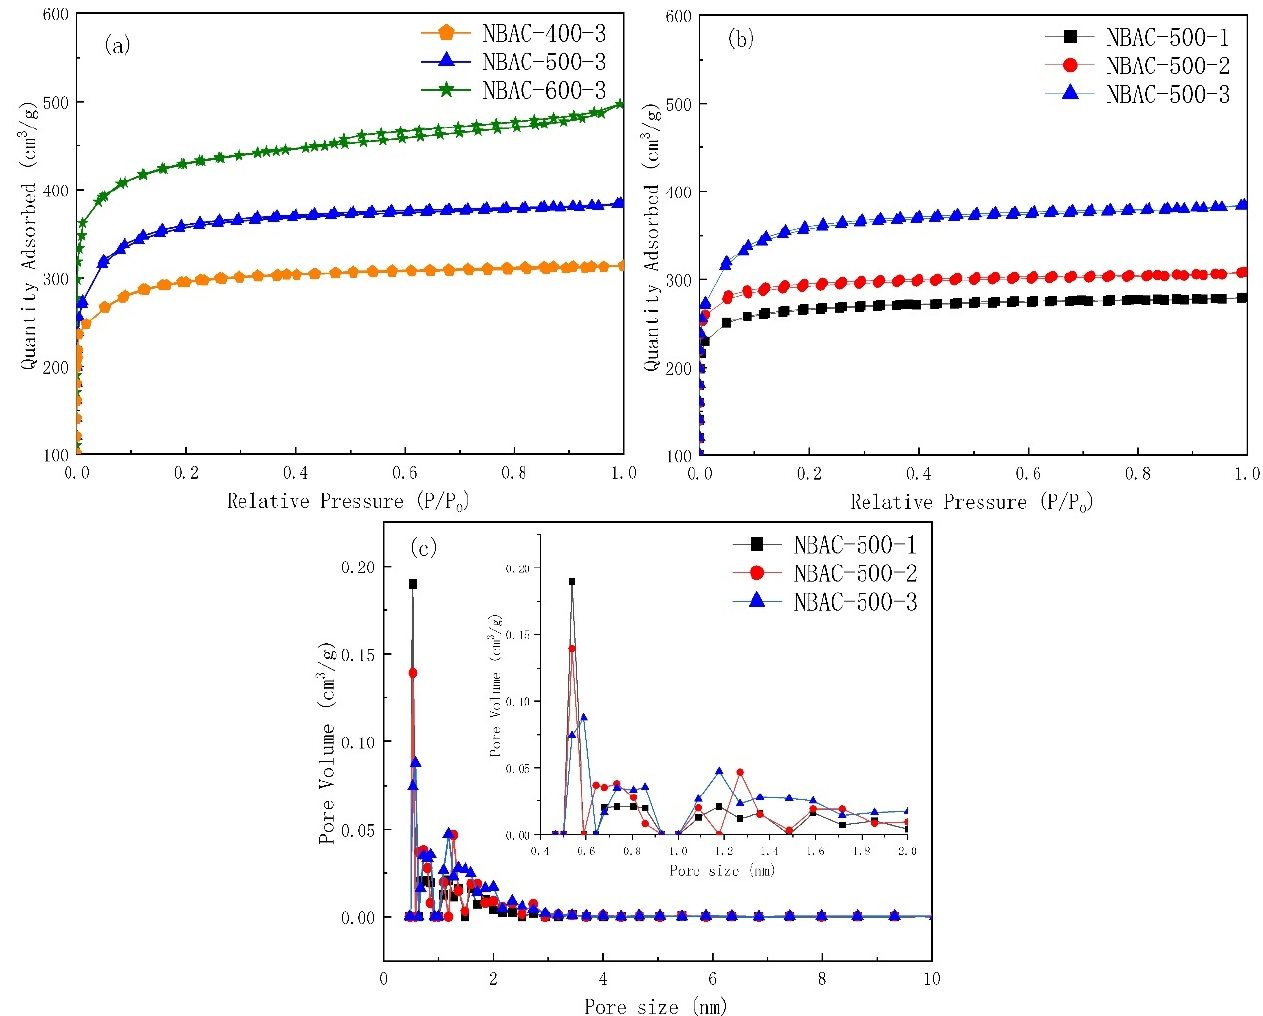
Figure 1. N 2 adsorption–desorption isotherm ( a , b ) of N-doped bamboo-based activated carbon synthesized by sodamide activation and its pore size distribution ( c ).